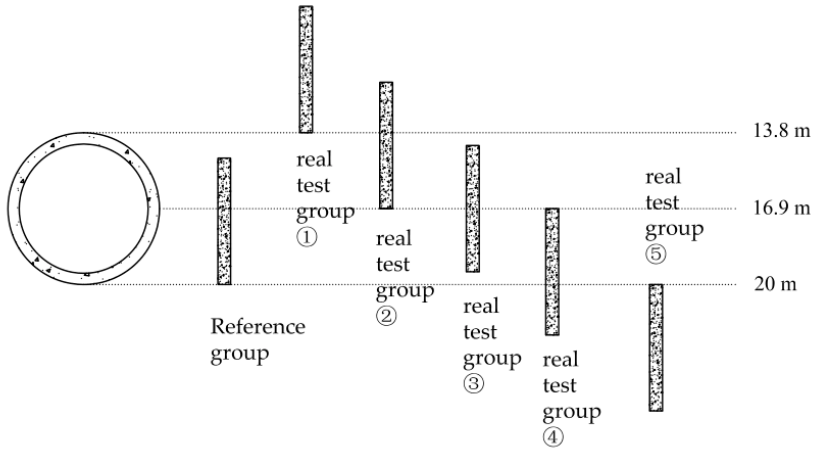
Figure 13. Comparison of different depths of the grouting section.